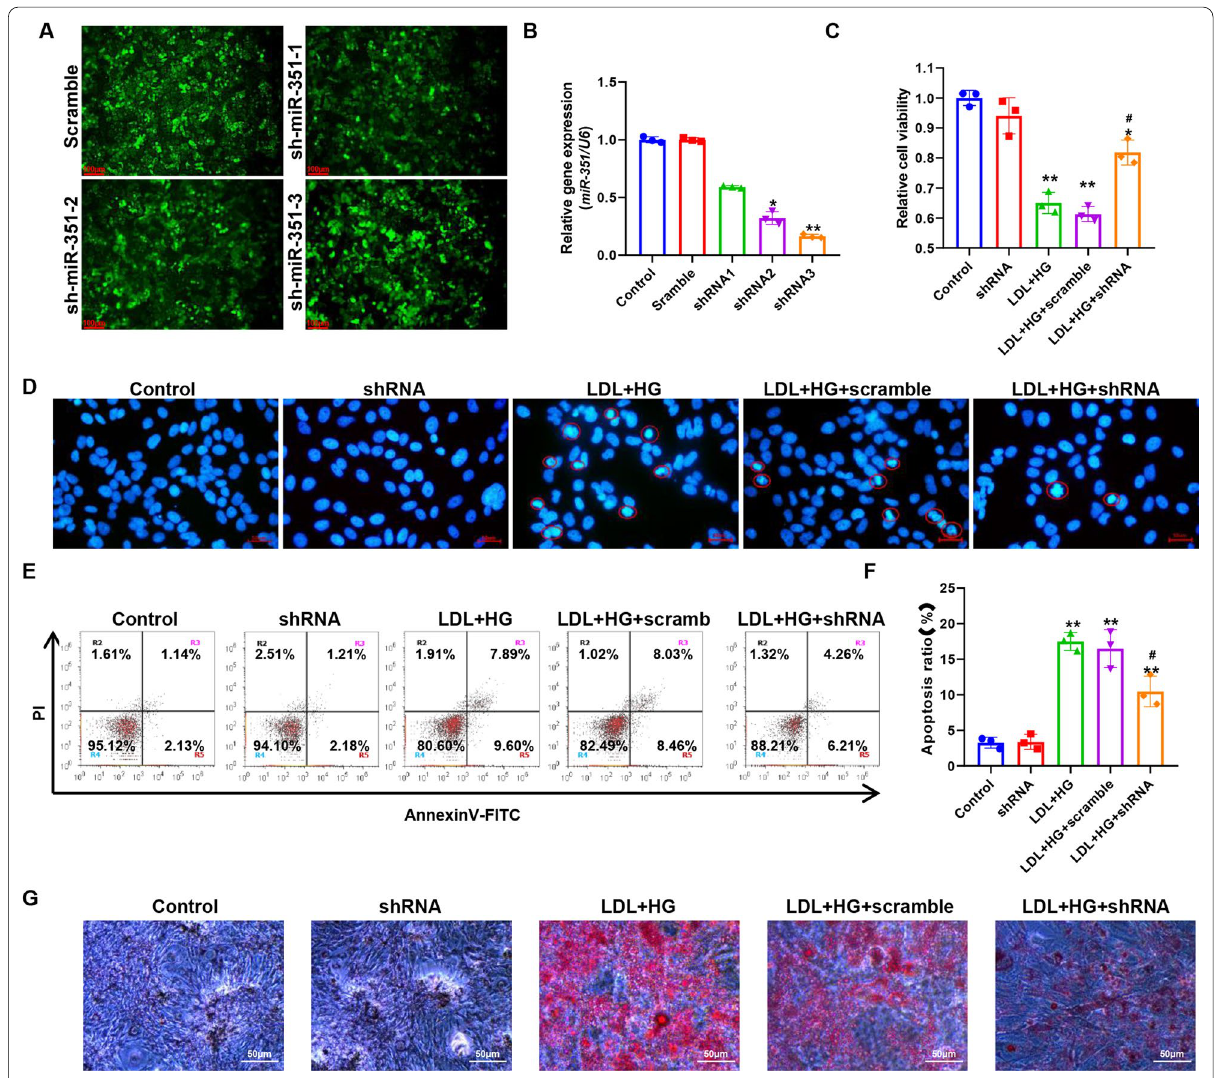
Fig. 6 Effect of miR-351 silencing on the atherosclerotic cell model. A Lentivirus was used to infect cells and deliver packaged shRNA plasmids, and the success of infection was determined by fluorescence microscopy. The scale bar represents 100 μm. B qPCR was used to detect the silencing efficiency of shRNA on the miR-351 gene in the three groups. C MiR-351 was treated with ox-LDL 30 mM glucose for 48 h, and MTT was used to + detect the activity of cells in each group. D DAPI (1 μg/ml) was used for nuclear staining of cells in each group, and apoptotic cells are shown in red circles. The scale bar represents 50 μm. E Flow cytometry was used to detect apoptosis. Annexin V-FITC fluorescence intensity is shown by the horizontal coordinates, and PI staining is shown by the vertical coordinates. Dead cells are present in the R2 quadrant, late apoptotic cells are in the R3 quadrant, normal cells are in the R4 quadrant, and early apoptotic cells are in the R5 quadrant. F Flow cytometry was used to detect apoptosis. G Oil red O stains cells with oil, and red stain indicates the oil-positive part. The scale bar represents 50 μm. **P < 0.01, *P < 0.05, vs. the control group. # P < 0.05, vs. LDL HG group. N 3 per + =